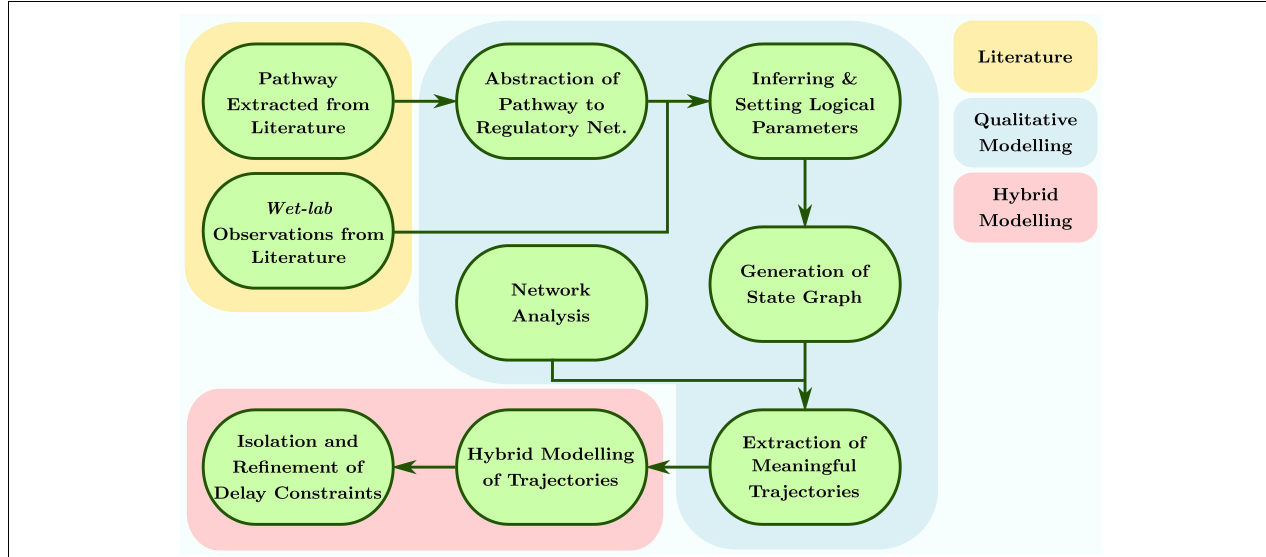
FIGURE 1 | The work-flow of the methodology applied in this